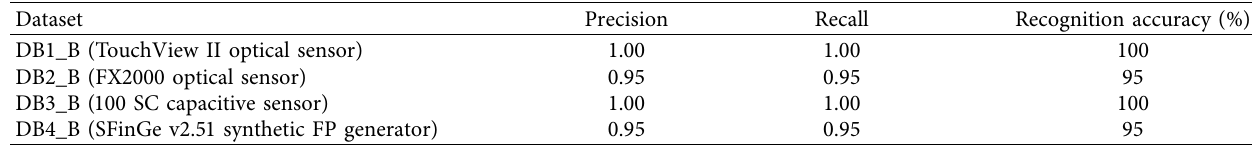
Table 4: Performance of various datasets.